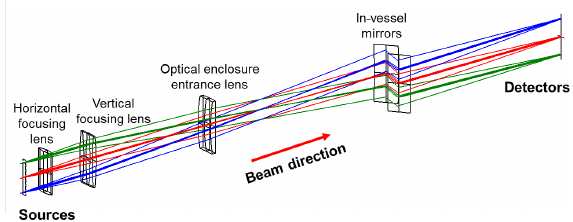
Fig. 9. Setup for integrated optics test for beam properties in laboratory